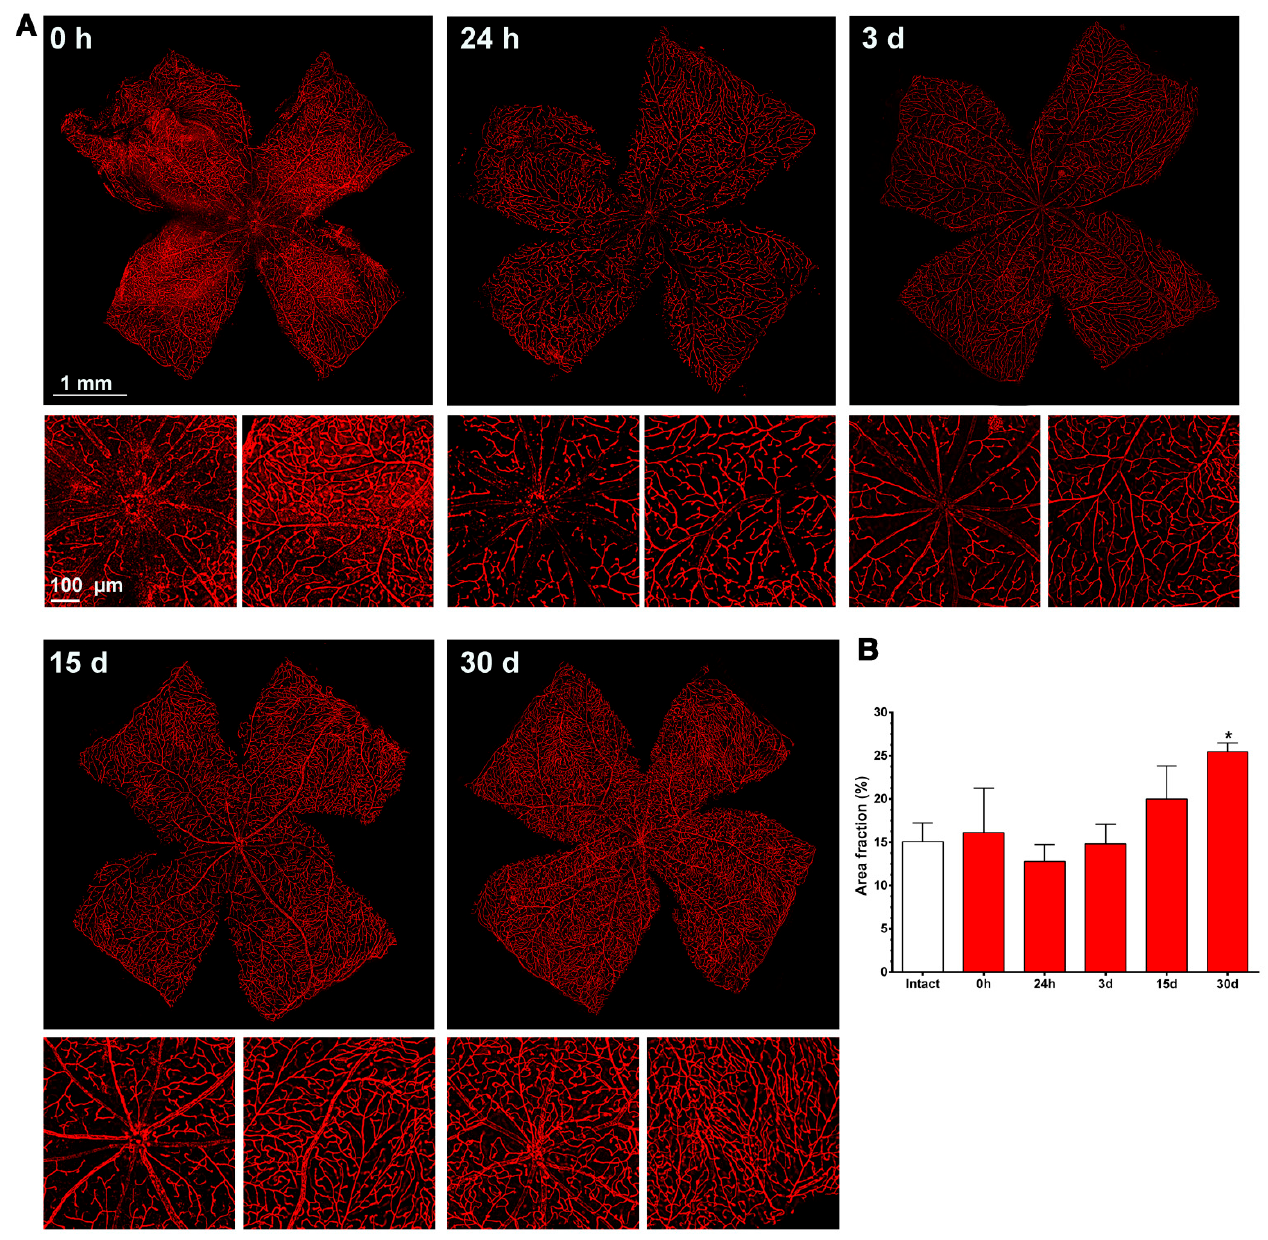
Figure 4. Changes in the retinal vasculature after transient ischemia. ( A ) Ly6c immunodetection showing the superficial plexus (P1) of ischemic retinas analyzed from 0 h (immediately after) to 30 days after the induction of the ischemia. Below each photomontage are shown magnifications of the optic nerve head or retinal periphery. ( B ) Bar graphs showing the area fraction of the retina covered by P1 ± standard deviation in intact and contralateral retinas. * Significant compared to intact retinas ( p < 0.05, Kruskal–Wallis, Dunn’s multiple comparisons test). 1 mm and 100 µm scale bars are for photomontages and magnifications, respectively.